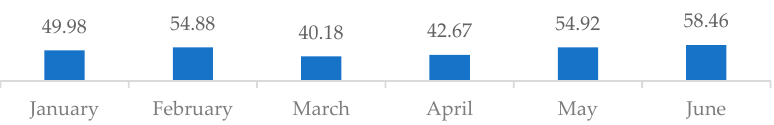
Figure 10. Sum of hourly photovoltaic generation, electricity consumption and surplus renewable generation from the 4 public buildings in Alfândega da Fé during the 6-month trial period. Source: Authors’ own elaboration.